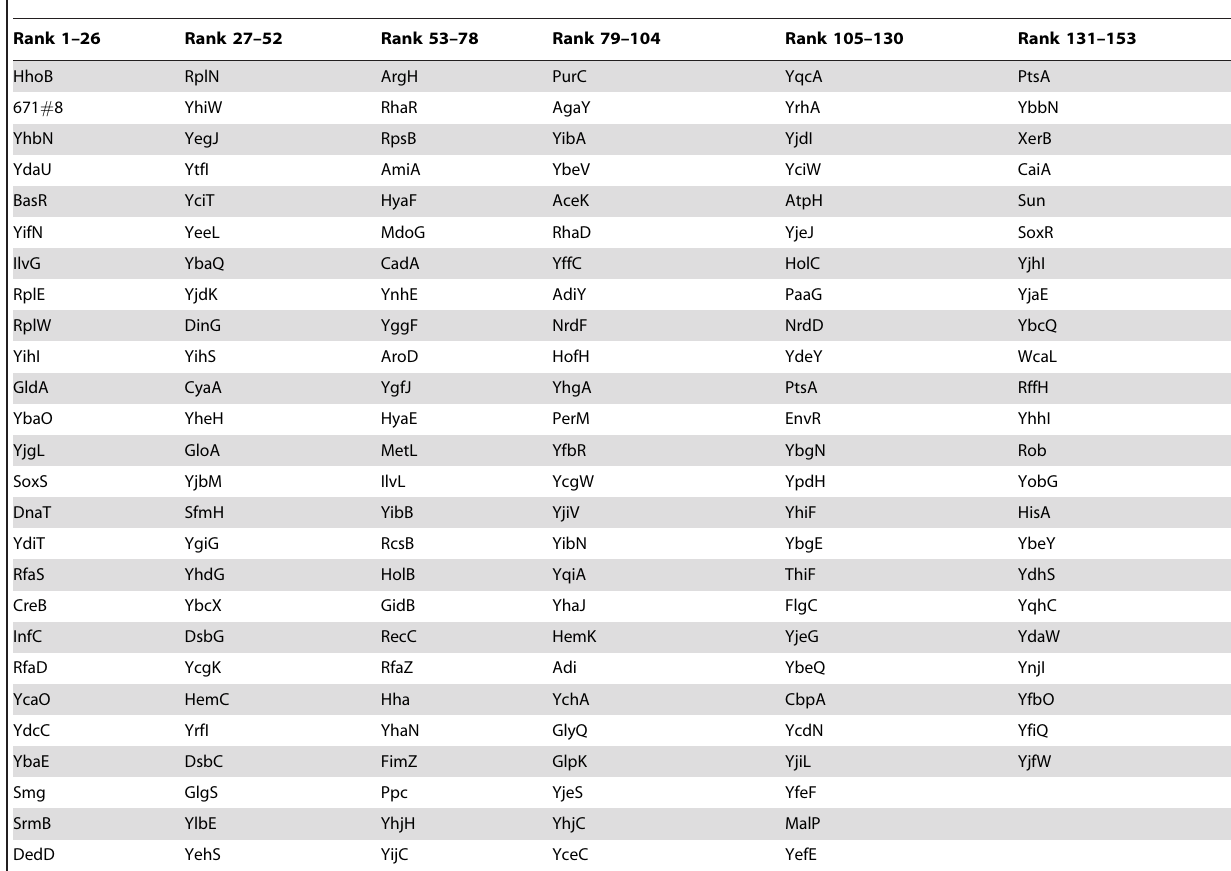
Table 1. The top 153